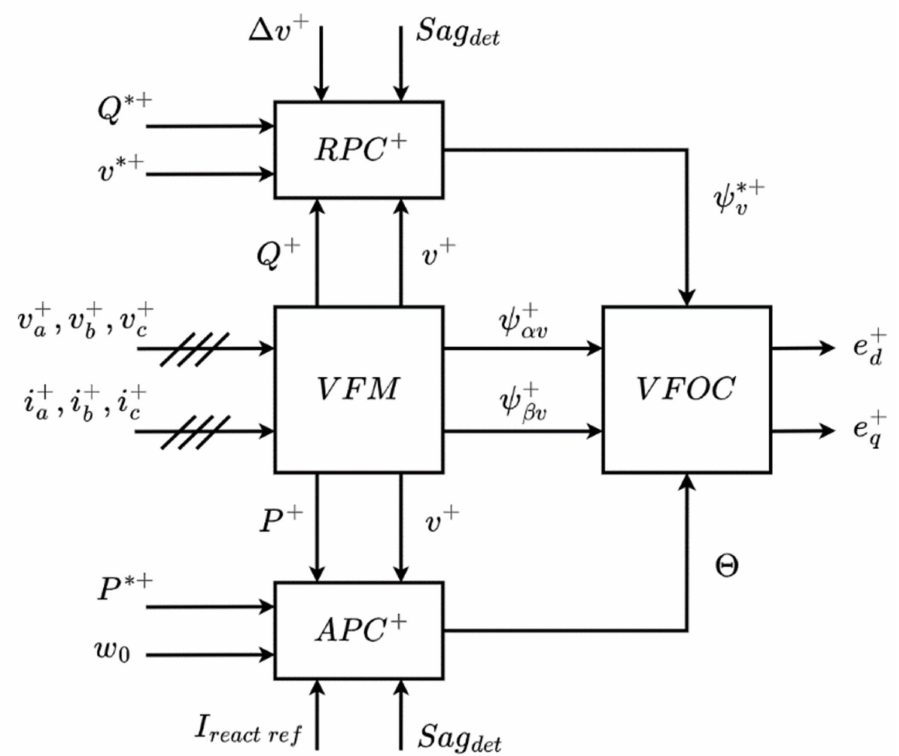
Figure 4. Positive sequence control